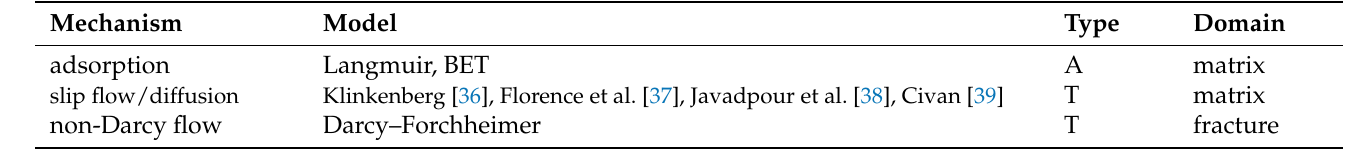
Table 2. Adsorption and transport, corresponding models and domain for the gas flow; A—adsorption, T—transport. Mechanism Model Type Domain adsorption Langmuir, BET slip flow/diffusion non-Darcy